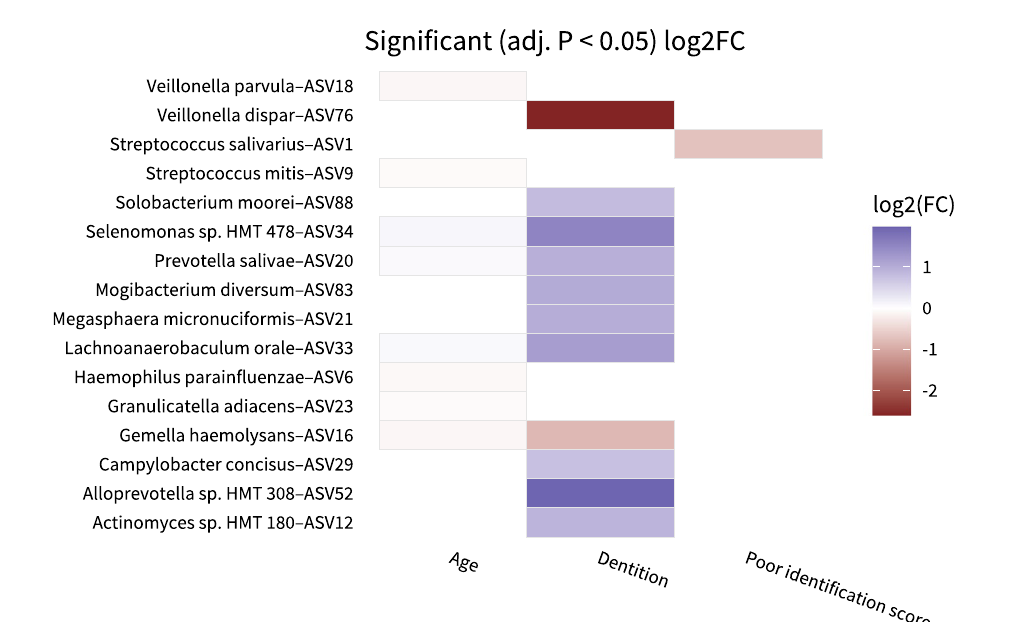
Figure 4. Microbiota taxa multivariately associated with age, dentition, poor taste, smell, appetite, and undernutrition outcomes. Heatmap depicting log2 fold change for taxa that are significantly (Benjamini– Hochberg adjusted p value < 0.05) associated with age, dentition, all poor smell scores, all poor taste scores, poor appetite, and undernutrition based on DESeq models. The association with age is adjusted for dentition, the association with dentition is adjusted for age, and the associations with all poor taste scores, all poor smell scores, poor appetite and undernutrition are adjusted for both age and dentition. Blue indicates taxa that increase in abundance with these conditions and red indicates taxa that decrease in